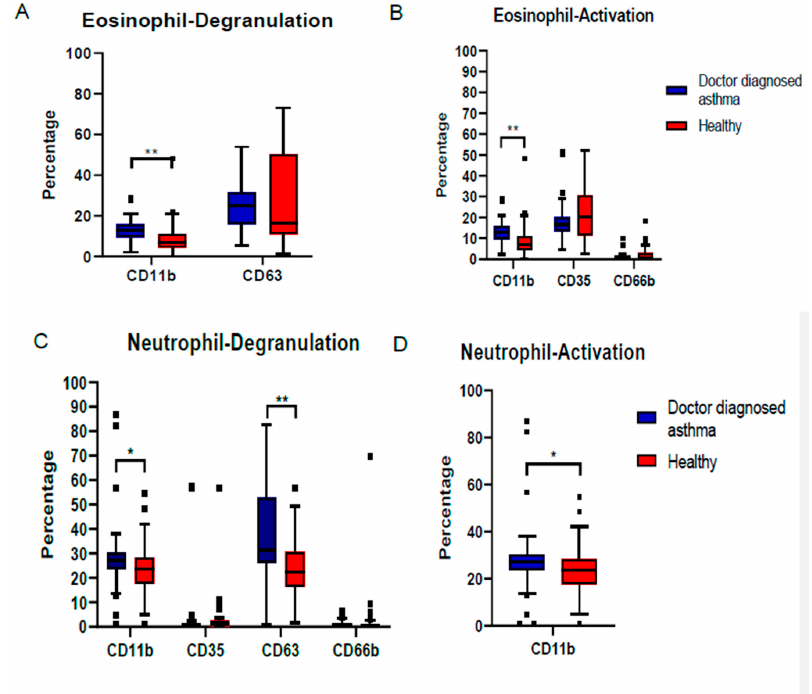
Figure 2. Expression profile of sputum granulocytes compared between the doctor-diagnosed asthmatic and healthy school children. Expression of degranulation and activation markers on eosinophil ( A and B ) and neutrophil ( C and D ). The expression of CD11b as the degranulation and classical activation marker is displayed twice in this graph. * p < 0.05, ** p < 0.001.